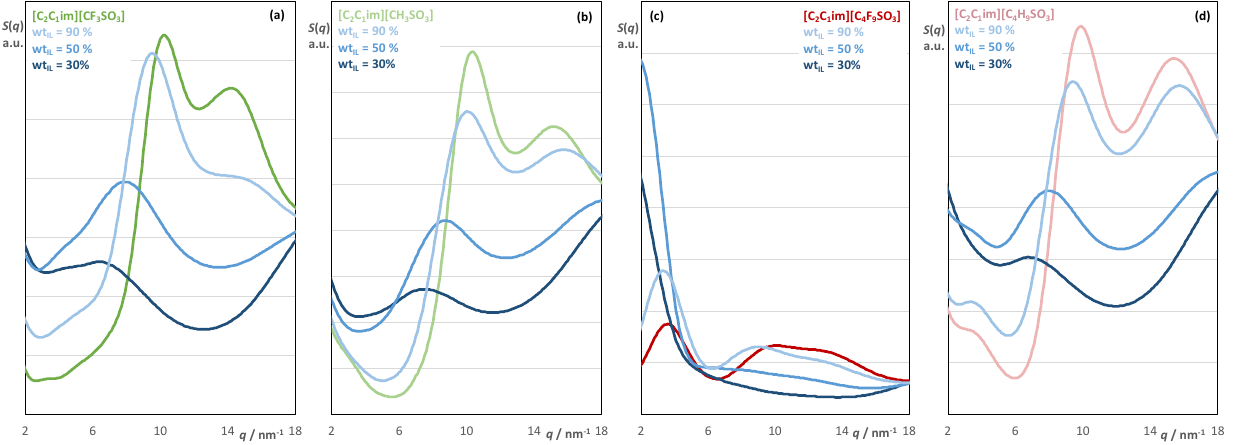
Figure 8. Structure factor for ( a ) [C 2 C 1 im][CF 3 SO 3 ]; ( b ) [C 2 C 1 im][CH 3 SO 3 ]; ( c ) [C 2 C 1 im][C 4 F 9 SO 3 ]; and ( d ) [C 2 C 1 im][C 4 H 9 SO 3 ]. Data for pure ILs calculated at 300 K and aqueous solutions with wt IL = 30% (X IL = 0.01–0.04), wt IL = 50% (X IL = 0.05–0.10), and wt IL = 90% (X IL = 0.23–0.49).